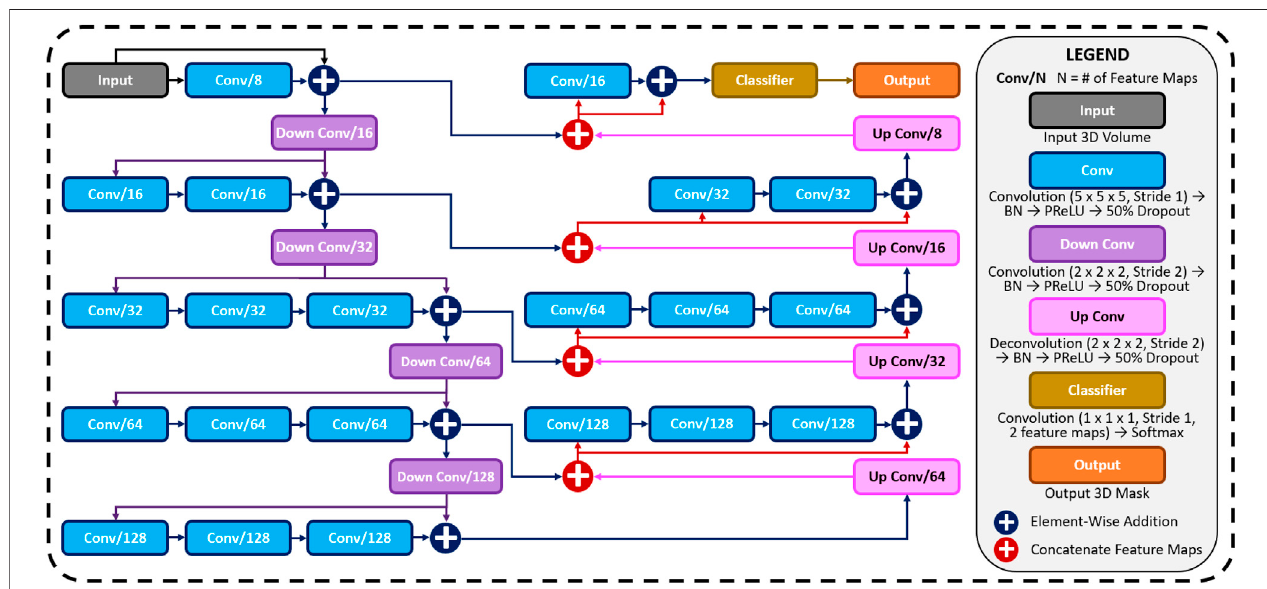
FIGURE 1 | The architecture of the proposed 3D convolutional neural network (CNN) for predicting the left atrial (LA) geometry from a point cloud obtained during clinical mapping. The number of kernels in each convolutional layer is shown, along with the type of convolution. The fl ow of the gradients between layers is also shown, with different operations for merging two layers. The legend shows the exact operations of each layer labelled with different colors. All parameters can be found in Table 1 . BN, batch normalization; conv, convolution; PReLU, parametric recti fi ed linear unit.